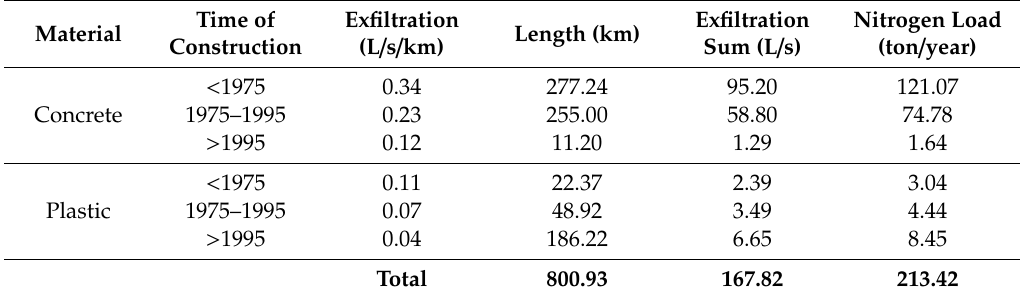
Table 2. Estimated exfiltration and nitrogen load from pipelines of the entire sewer system